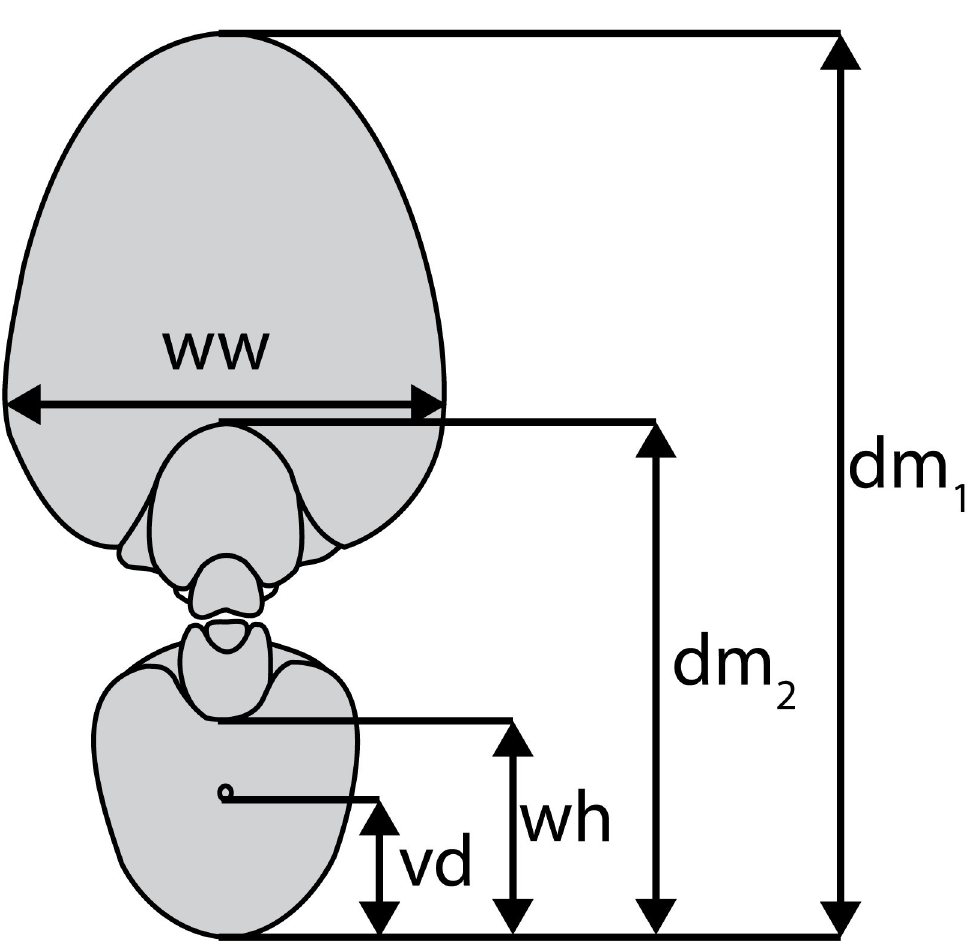
Fig 2. Cross-section of Nautilus macromphalus with measured morphological conch parameters. ww = whorl width, dm = conch diameter, wh = whorl height, ww = whorl width, and vd = distance between the ventral edge of the siphuncle and the ventral edge of the